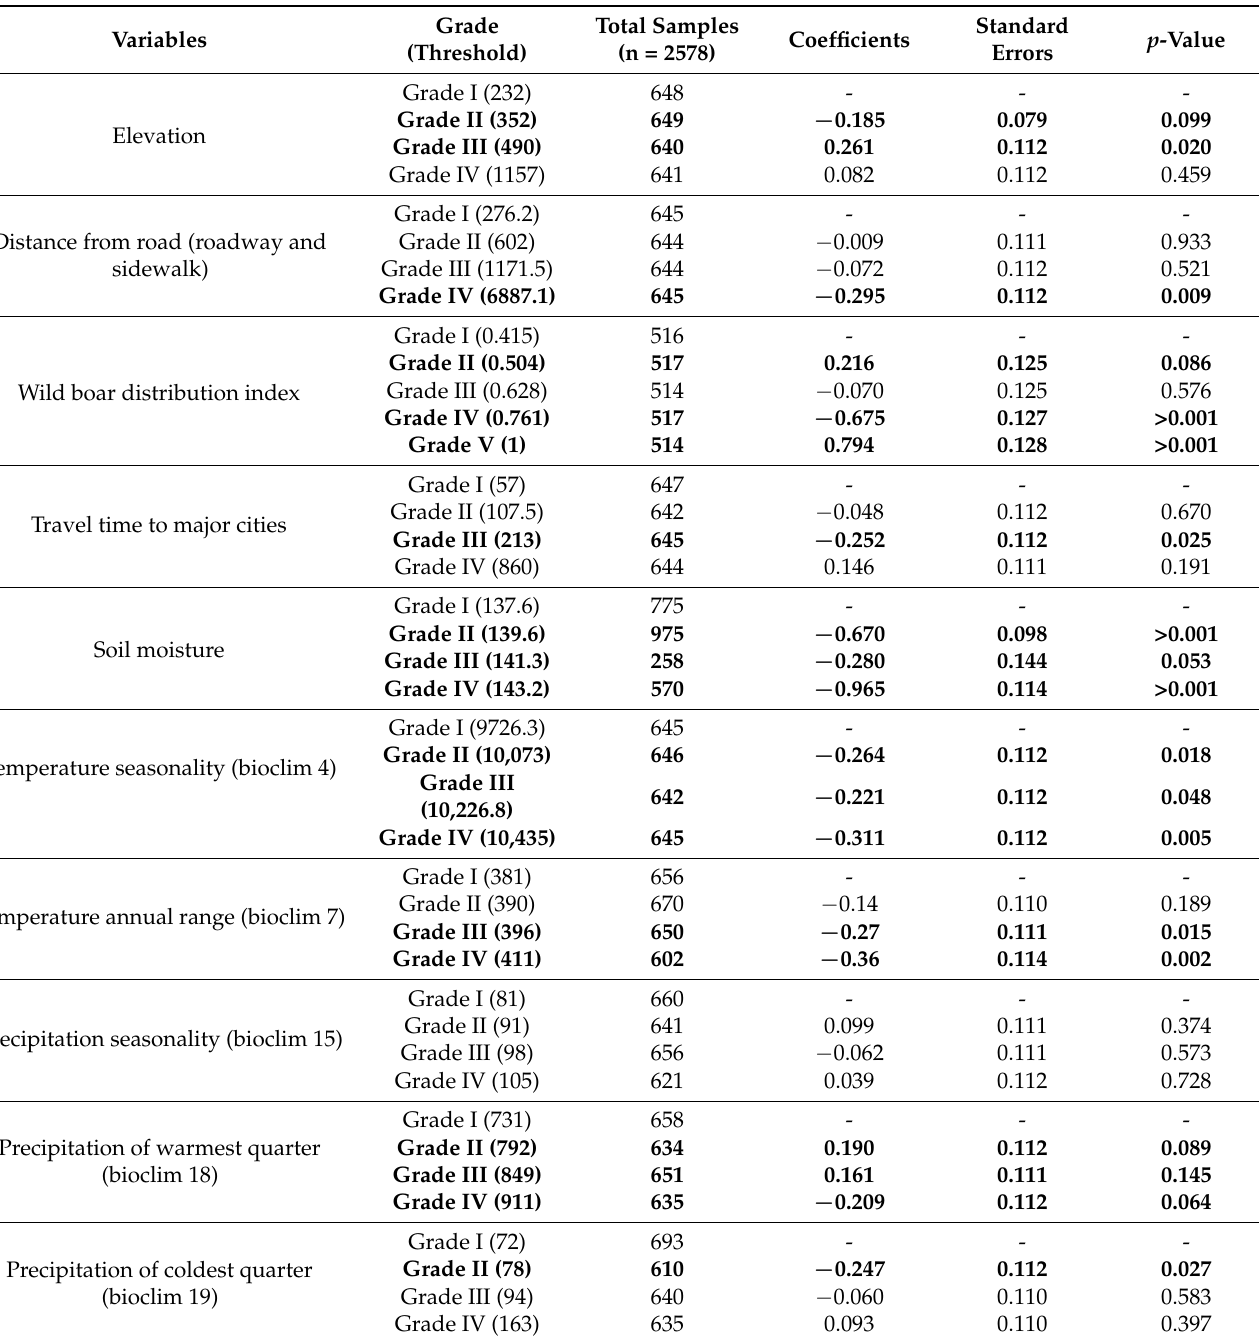
Table 2. Results of univariate analysis: the relationship between response and explanatory variables. Each explanatory variable was categorized (equally divided from grade I to a maximum of V